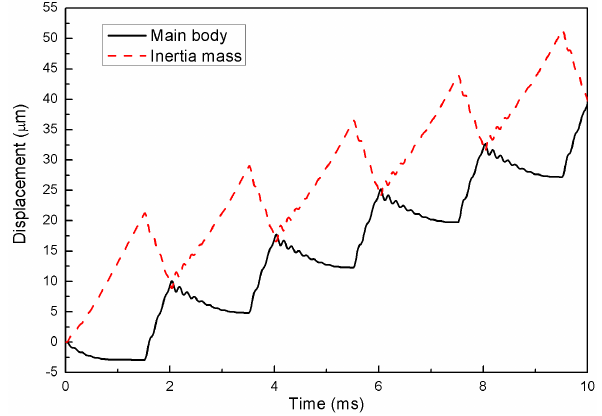
Figure 7. The robot and physical set up for testing.